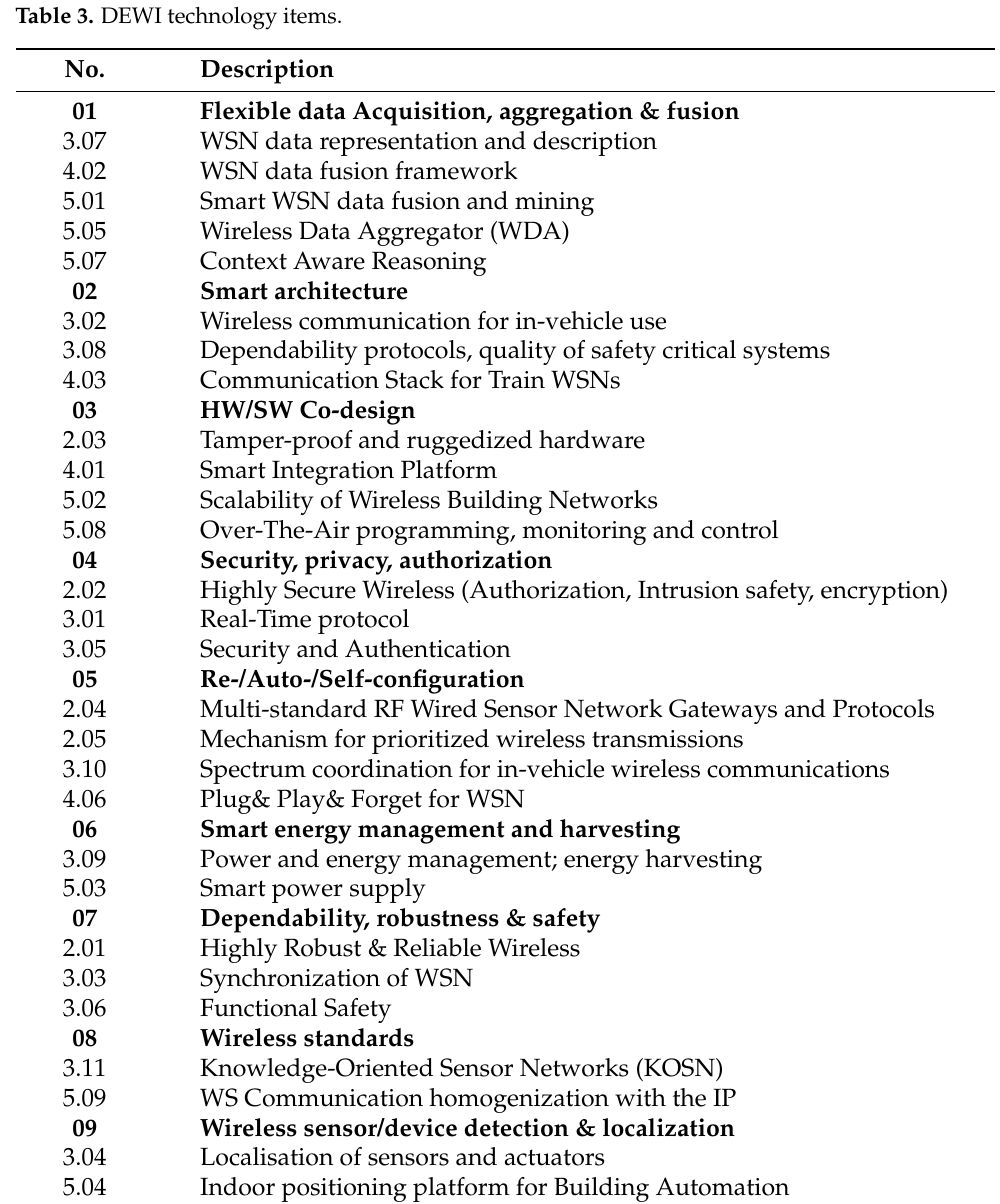
Table 3. DEWI technology